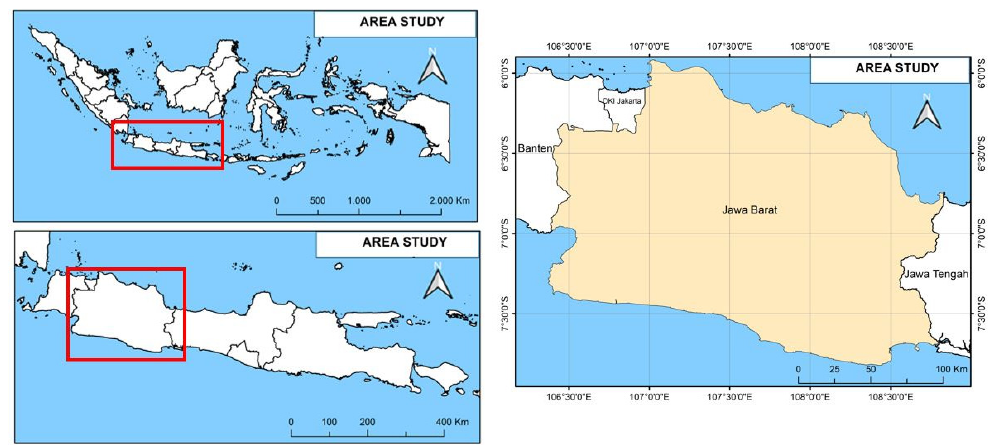
Figure 1. Study area: West Java Province, Indonesia.